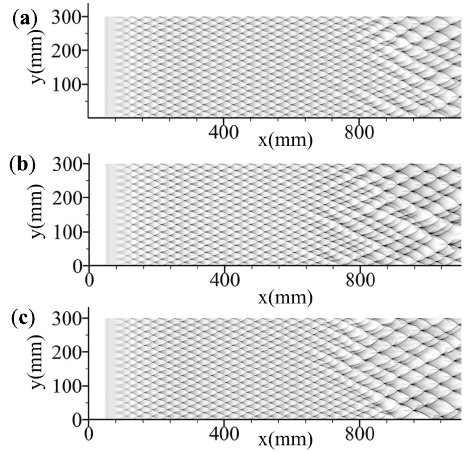
Figure 4. Numerical resolution test for cellular structures, ( a ) 16 pts/ ∆ I , ( b ) 32 pts/ ∆ I , and ( c ) 48 pts/ ∆ I